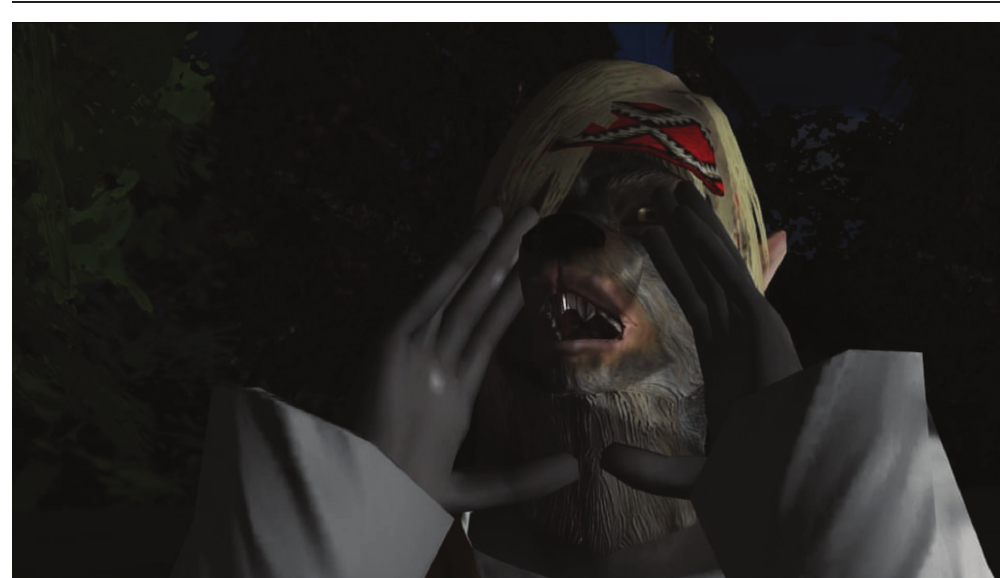
Figure 1: Werewolf transformation in The